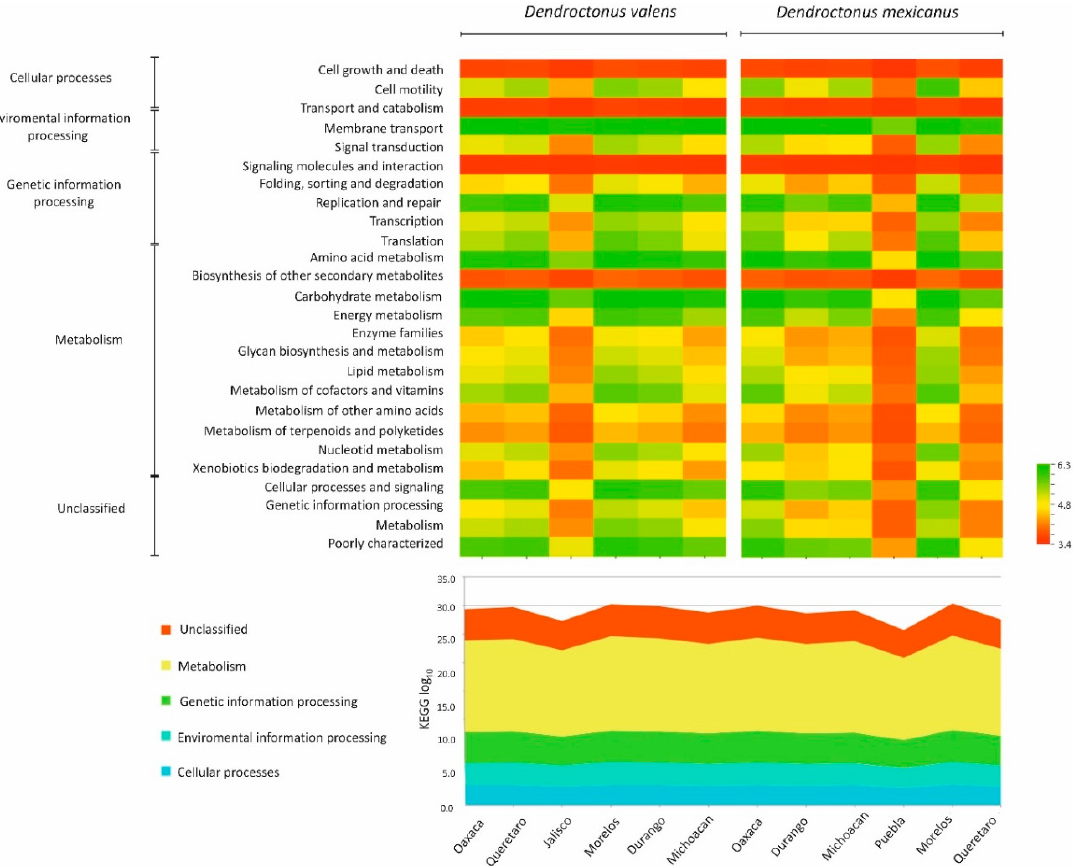
Figure 6. Heatmap of PICRUSt-inferred genes of bacterial communities of Dendroctonus valens and D. mexicanus . The range of colors indicates the relative abundance of metabolic pathways for each sample. Dark colors (green and yellow) indicate higher abundance and light (orange and red) ones lower abundance. The dendrogram shows the dissimilarities between the potential metabolic pathways of different bacterial communities clustered in KEGG 2 level. The relative abundance of the most important metabolic pathways in the KEGG 1 level on a log 10 scale is shown below the heatmap figure.